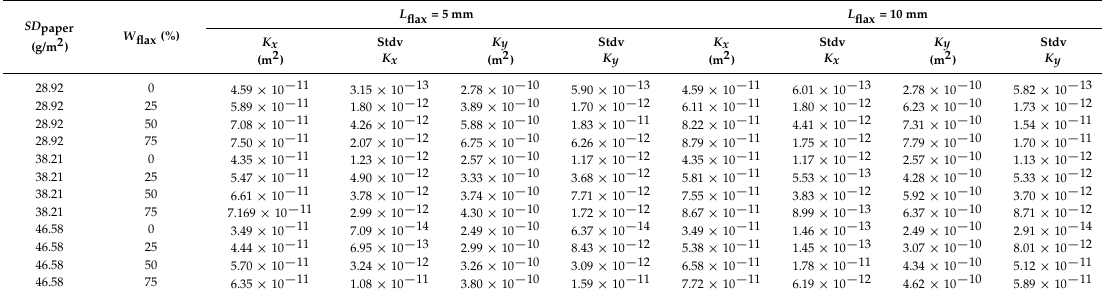
Table 6. Reinforcement permeability obtained from Equation